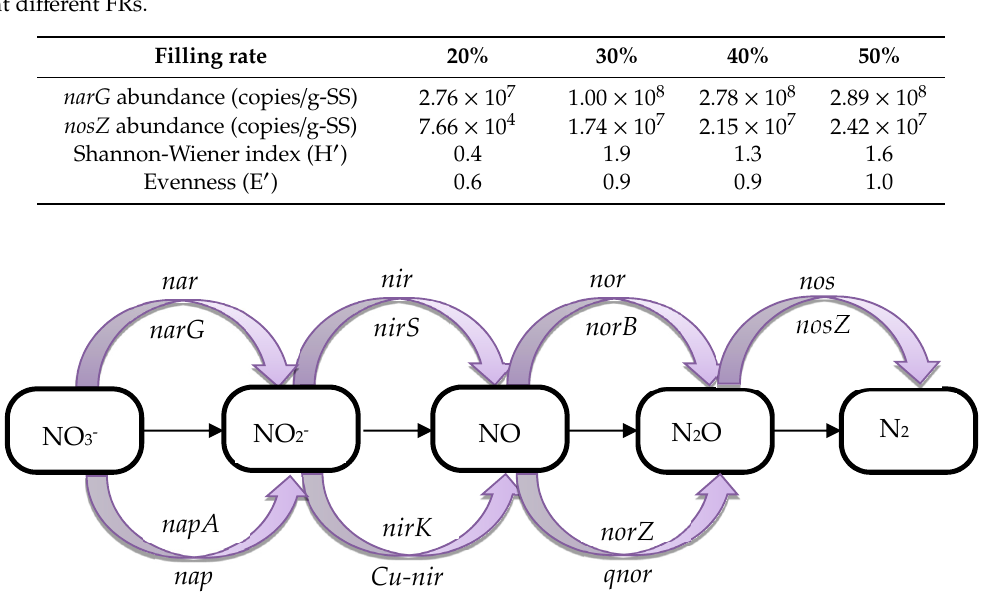
Table 3. Distribution of denitrifying bacteria functional genes and Shannon-Wiener index with evenness at different FRs.